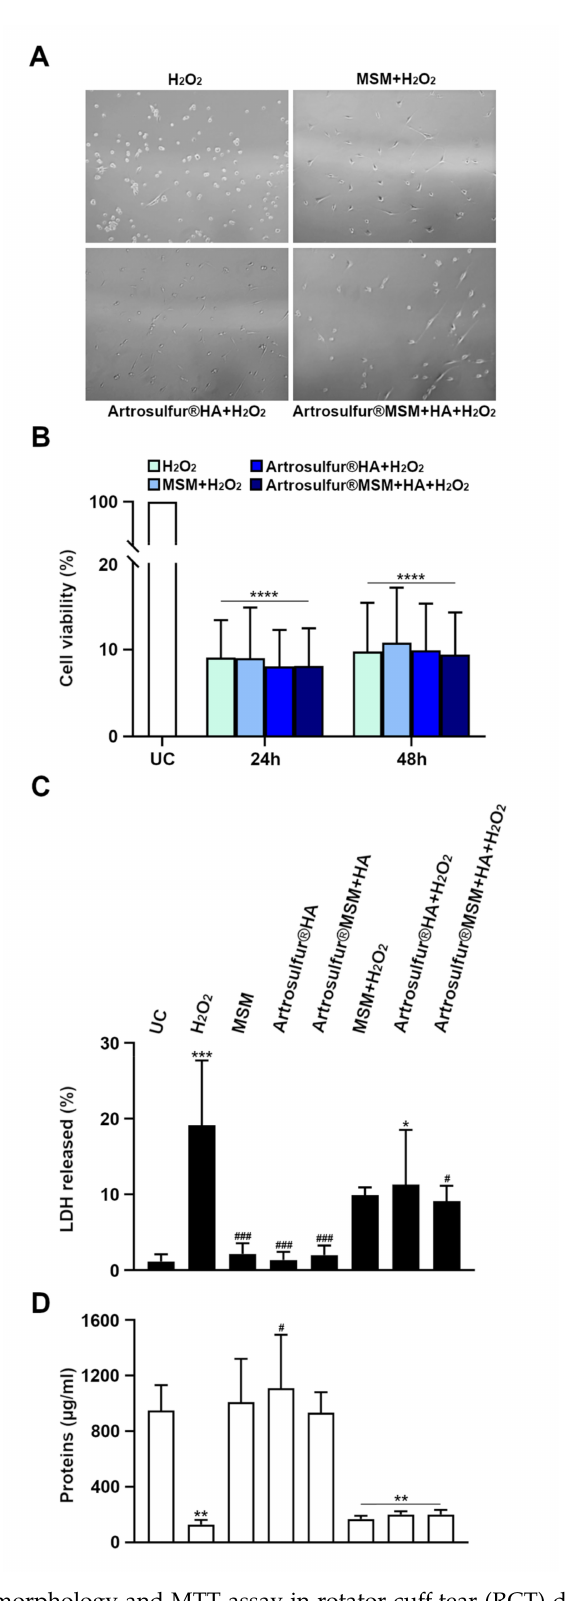
Figure 2. ( A , B ) Cell morphology and MTT assay in rotator cu ff tear (RCT)-derived tenocytes that were treated with H 2 O 2 for 0, 24, and 48 h, respectively, with or without MSM, Artrosulfur HA ® , or Artrosulfur ® MSM + HA: ( A ) Cell morphology was observed by optical microscopy after 48 h